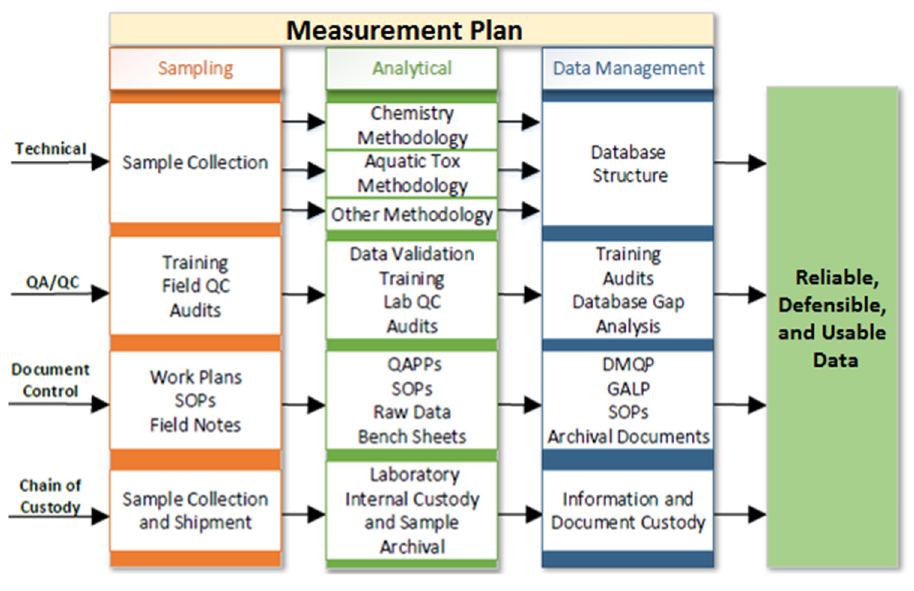
Figure 1. Measurement Plan.